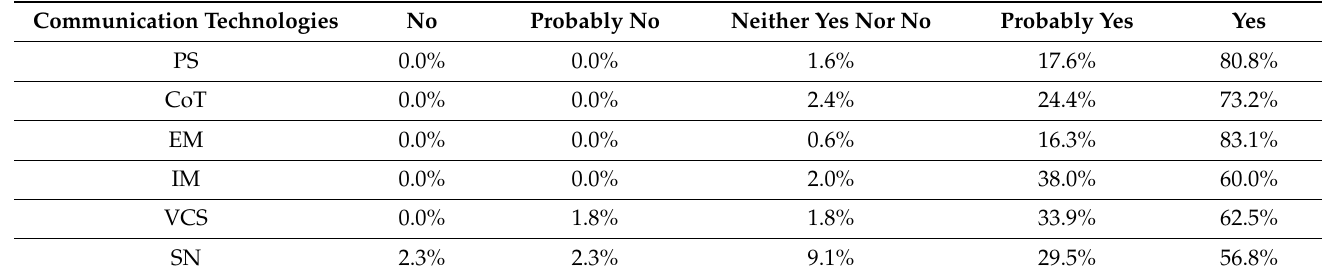
Table 17. Intention of future use of communication technologies by teachers. Communication Technologies